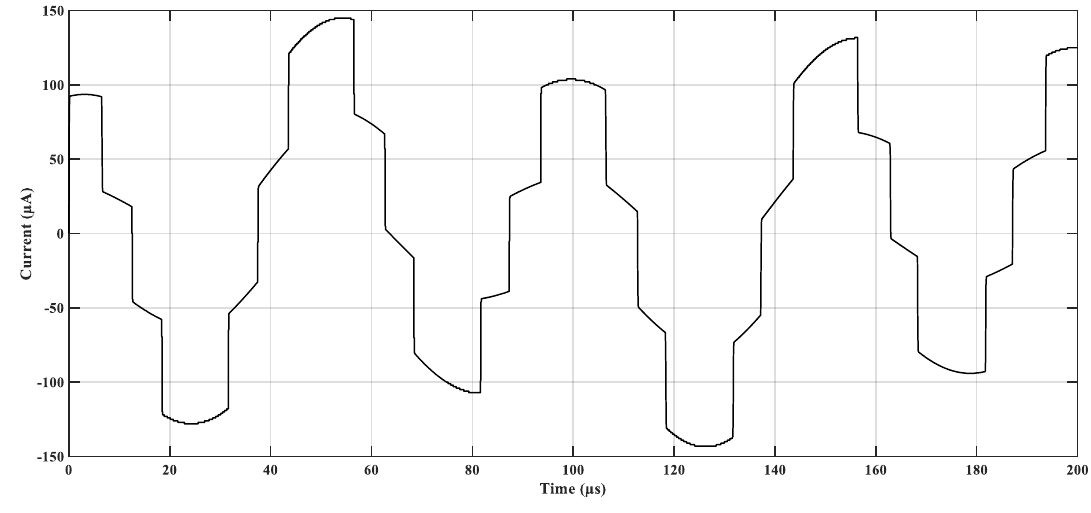
Figure 10. Common-mode current with the ACMVC.